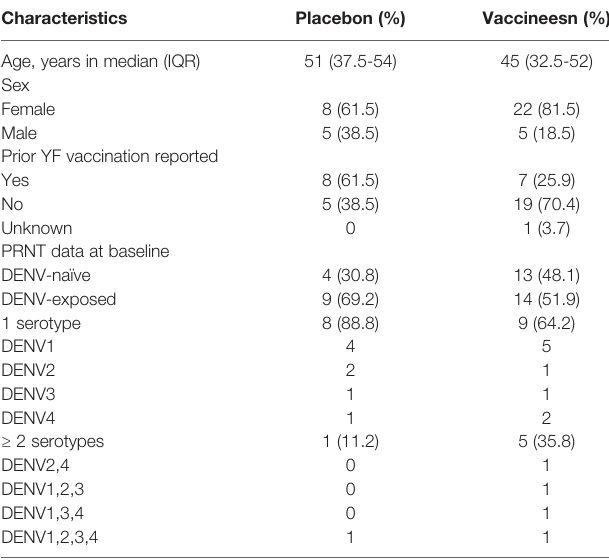
TABLE 1 | Baseline characteristics of the 40 participants enrolled in the Phase II Butantan-DV Clinical Trial.